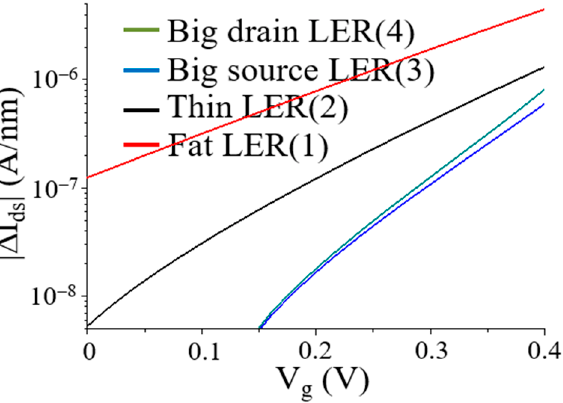
Figure 8. Analytical results of drain currents | ∆ I ds | with FWRs at gate length L = 5-nm due to gate